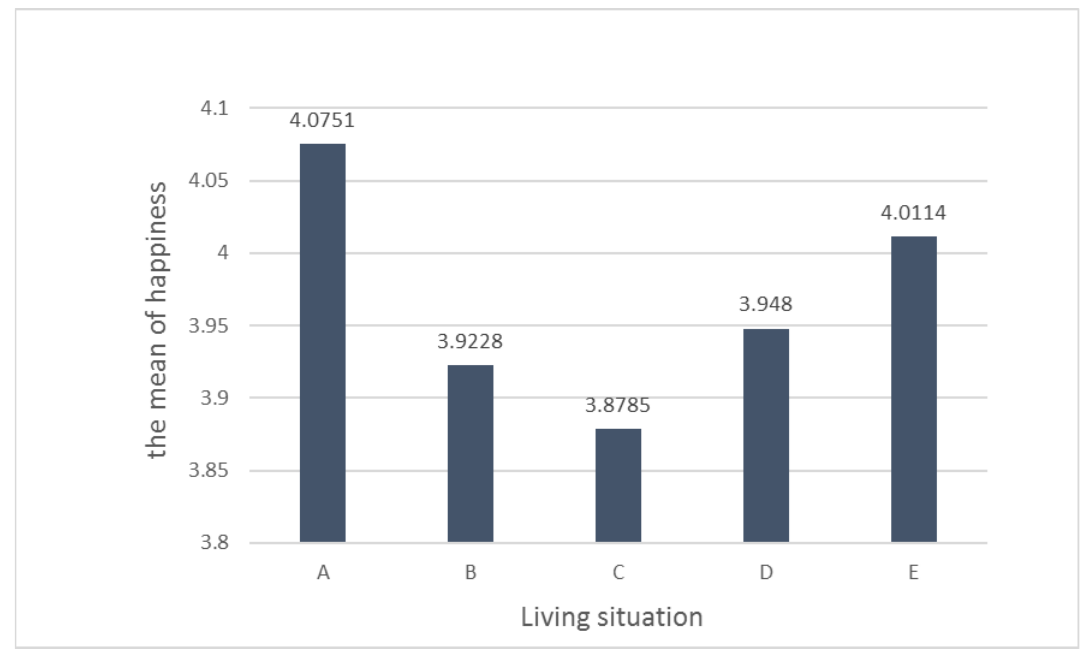
Figure 1. Bar chart for living situation distribution and the mean of happiness.